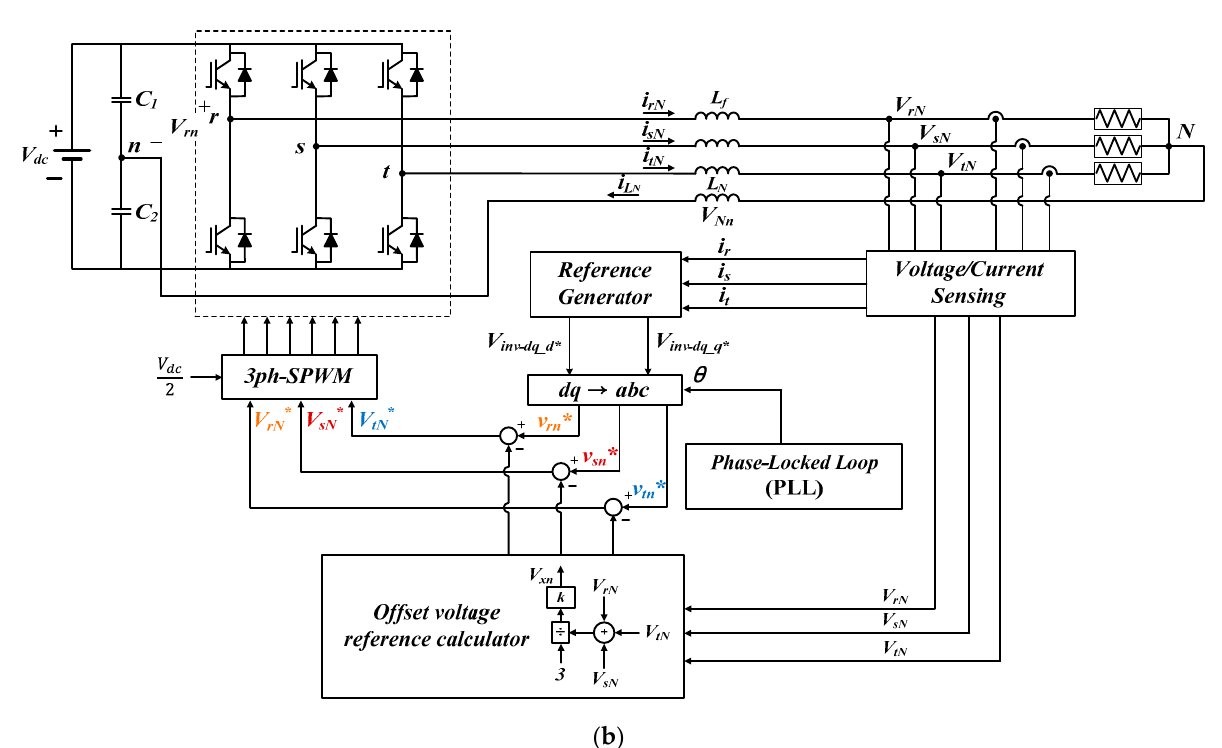
Figure 9. Experimental setup and control block diagram; ( a ) experimental setup; ( b ) block diagram of the proposed imbalance compensation using offset voltages.